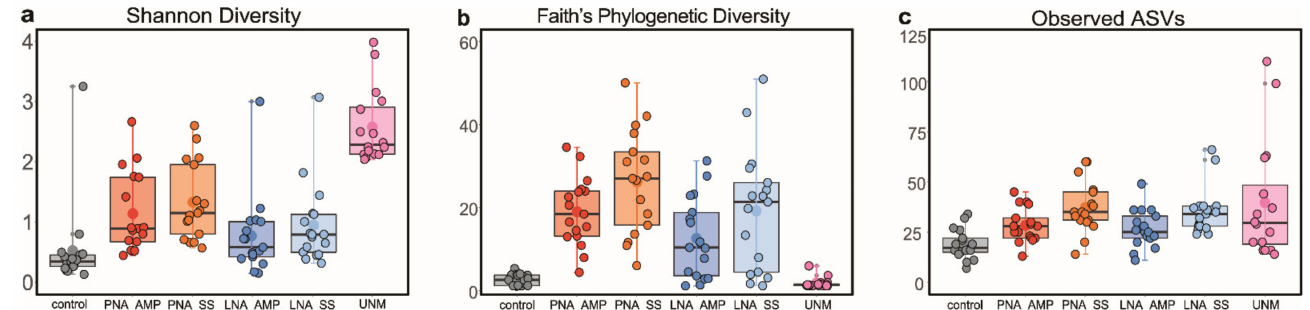
Figure 5. Comparison of the efficiency of blocking methods based on alpha diversity. Universal primer